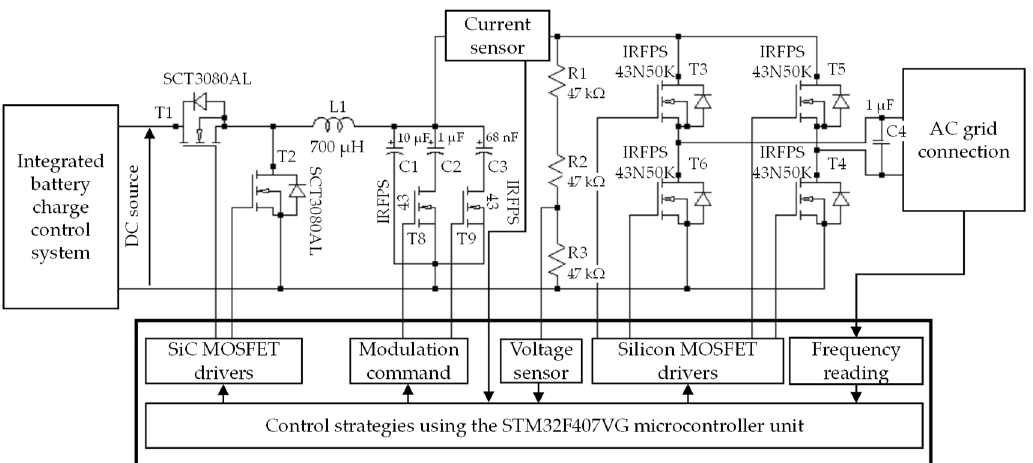
Figure 9. Electrical diagram of the power circuit of the converter. Table 2. A selection of the main components.